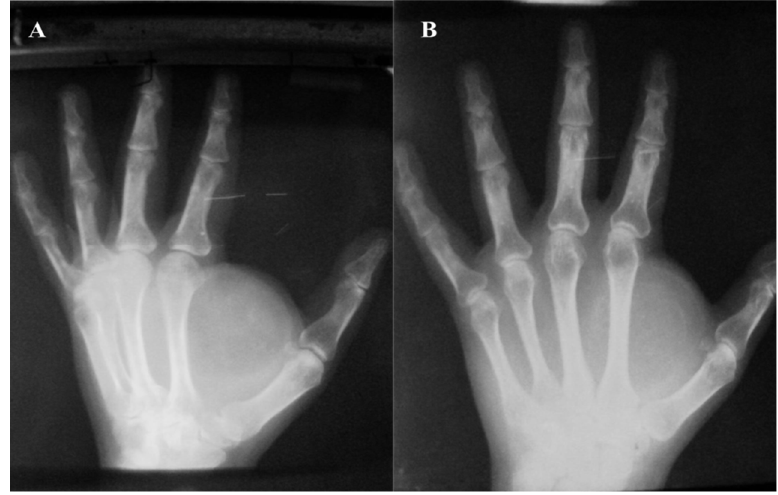
Figure 3. Lipoma in the hipothenar eminence—radiological aspect ( A , B ).